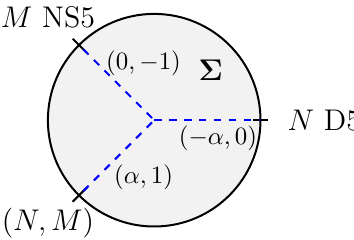
Figure 11. Disc representation of the 3-pole solutions with residues given in (4.32). The dashed blue line shows a string junction connecting all three poles, with (cid:11) = N=M